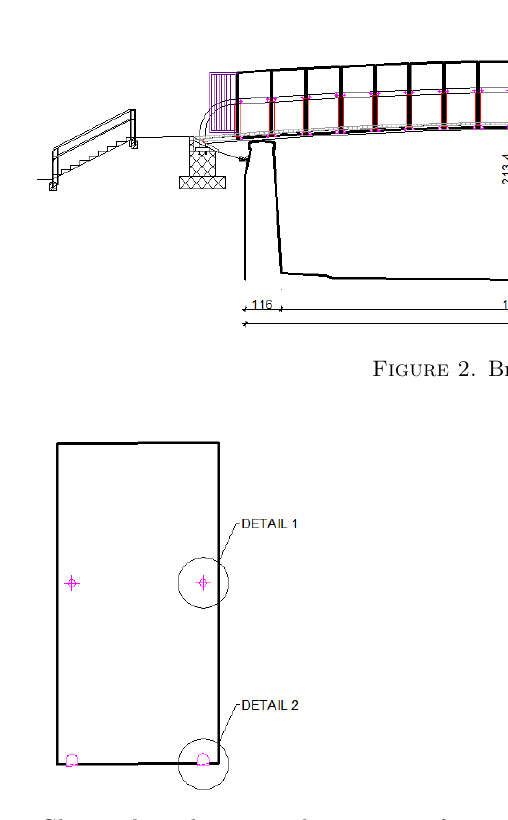
Figure 3. Glass railing element with positions of attachment details.